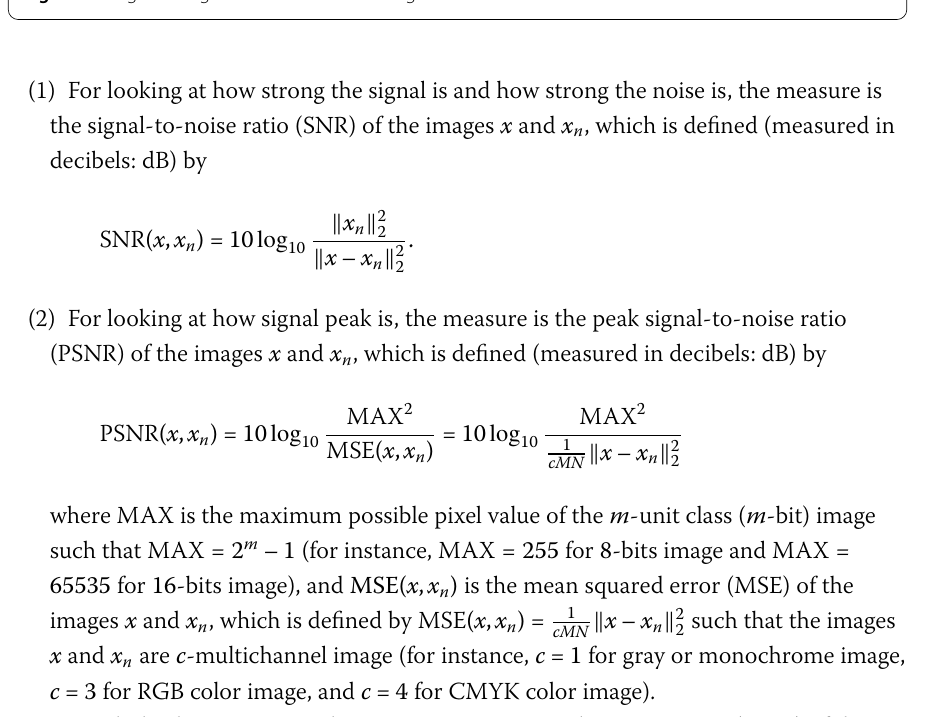
Figure 1 Original images and their 2D three-stage Haar wavelet